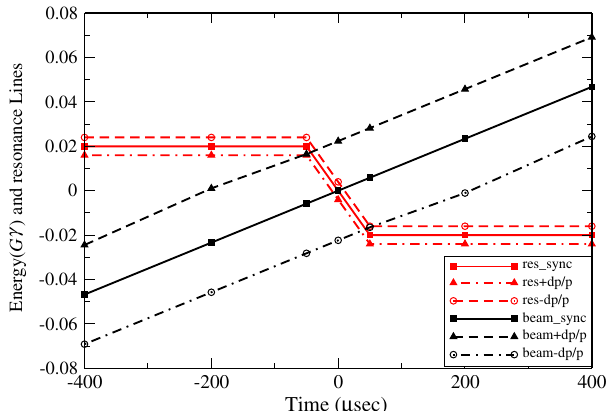
FIG. 9. This plot is similar to Fig. 8 except it is for G γ ¼ 36 þ ν ¼ 44 . 7 resonance. The resonance lines (red) are given by x Eq. (5) for positive and negative momentum spreads. Note that in this case, the locations of positive and negative momentum spreads boundaries are reversed in comparison to the case of G γ ¼ 54 − ν ¼ 45 . 3 . The portion of beam that benefits from the x tune jump is only slightly smaller. Still, the plot shows that particles within FWHM (76% beam) benefit from the tune jump in this